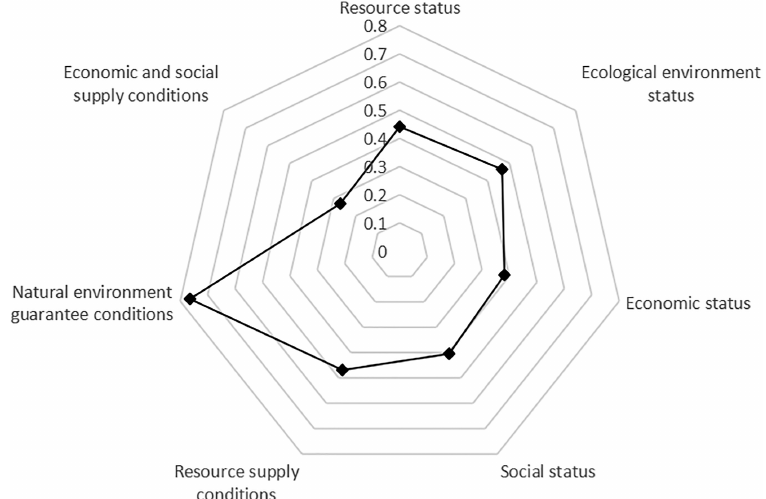
Figure 9. Change trend of the main obstacle factors of the comprehensive development prospect index of the Changdao Island Group